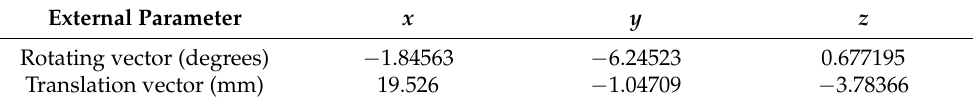
Table 2. External parameter calibration